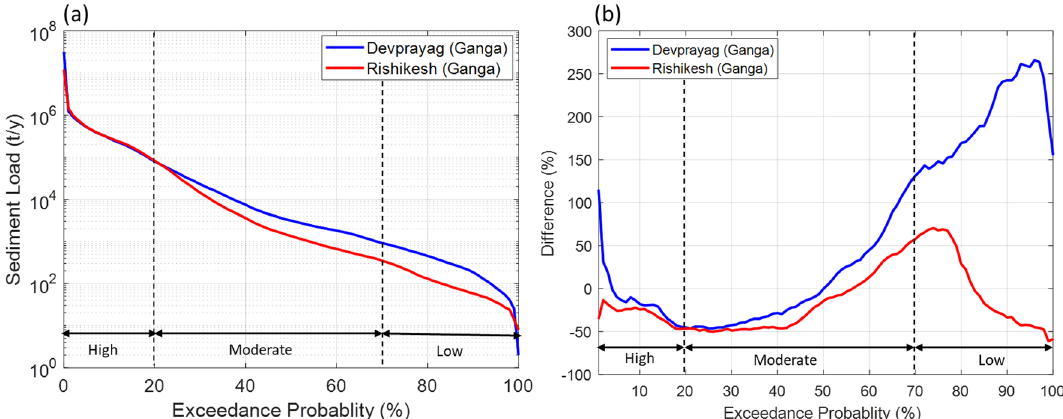
Figure 6. (a) Sediment duration curves (SDCs) of Devprayag (blue) and Rishikesh (red) for the period 1970–2015. The high sediment fluxes (20% <) are comparable for both stations. However, the peak sediment fluxes are slightly higher for the Devprayag station. Further, the moderate (20–70%) and low sediment fluxes (> 70%) are an order of magnitude higher for Devprayag than the Rishikesh station. (b) Difference (%) between pre-and post-1995 SDCs of Devprayag (blue) and Rishikesh (red) stations. The peak sediment flows have been increased (120%) at Devprayag. In contrast, the peak sediment fluxes have been decreased (− 25%) at Rishikesh. Furthermore, the moderate sediment fluxes have also been reduced (up to 50%) at both stations. However, moderate and low sediment fluxes greater than 50% and 55% exceedance probability are increased from their pre-1995 values at both